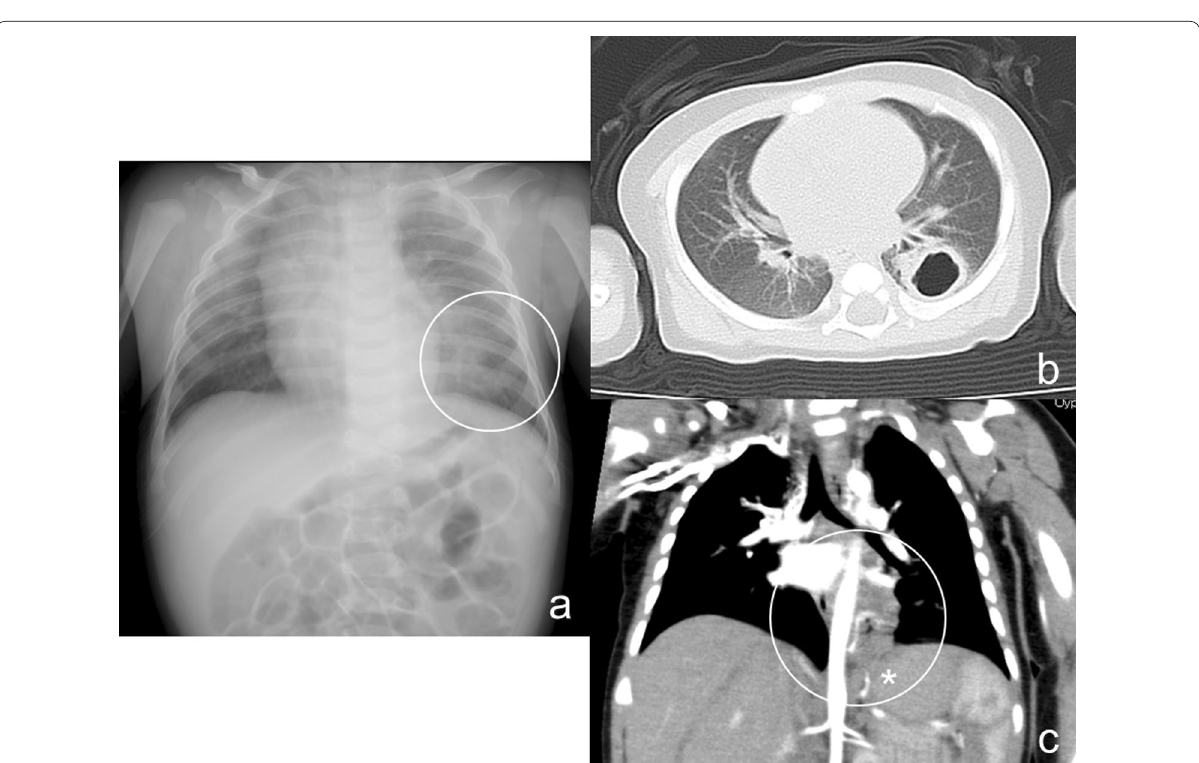
Fig. 1 The chest radiograph showed a ring-shaped infiltration 2 cm in diameter in the lower left lung field ( a ). Contrast-enhanced computed tomography ( b , c ). CT scans led to the diagnosis of a lung abscess in the left lower intralobar pulmonary sequestration forming a tumor-like lesion with aberrant arteries (asterisk) from the abdominal cavity